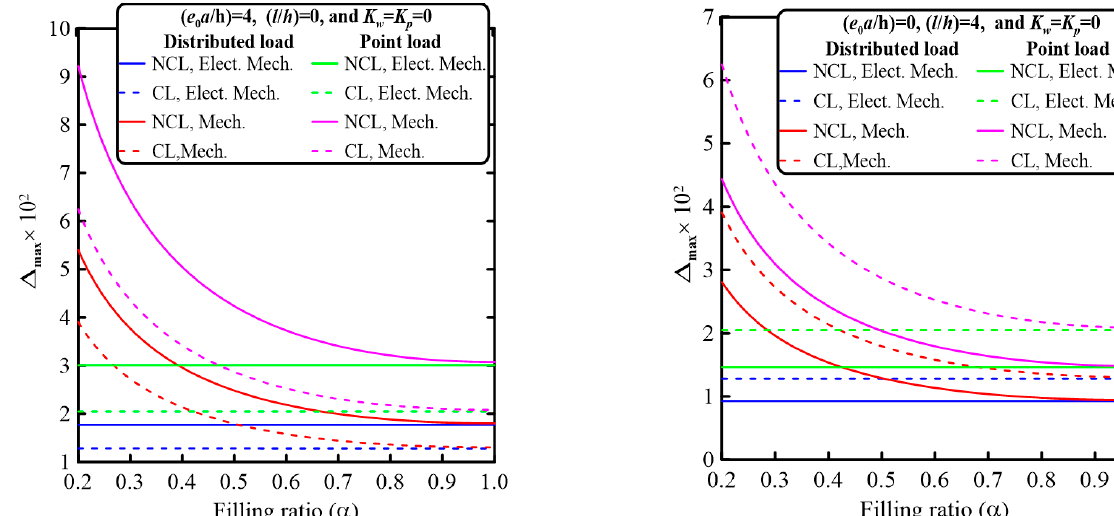
Figure 6. Variation in the maximum transverse deflection Δ max with the perforation filling ratio α for nonclassical and classical electromechanical and mechanical behavior under uniformly distributed and point loads at different values of the nonclassical and elastic foundation parameters at N = 4 and beam aspect ratio L / h = 20, α = 0.2 to 1, e 311 = − 4.1 C/m 2 , μ 3111 = 5 × 10 − 8 C/m, a 33 = 7.124 × 10 − 9 C/m 2 K, and K p = 0, 2 and K w = 0, 20.